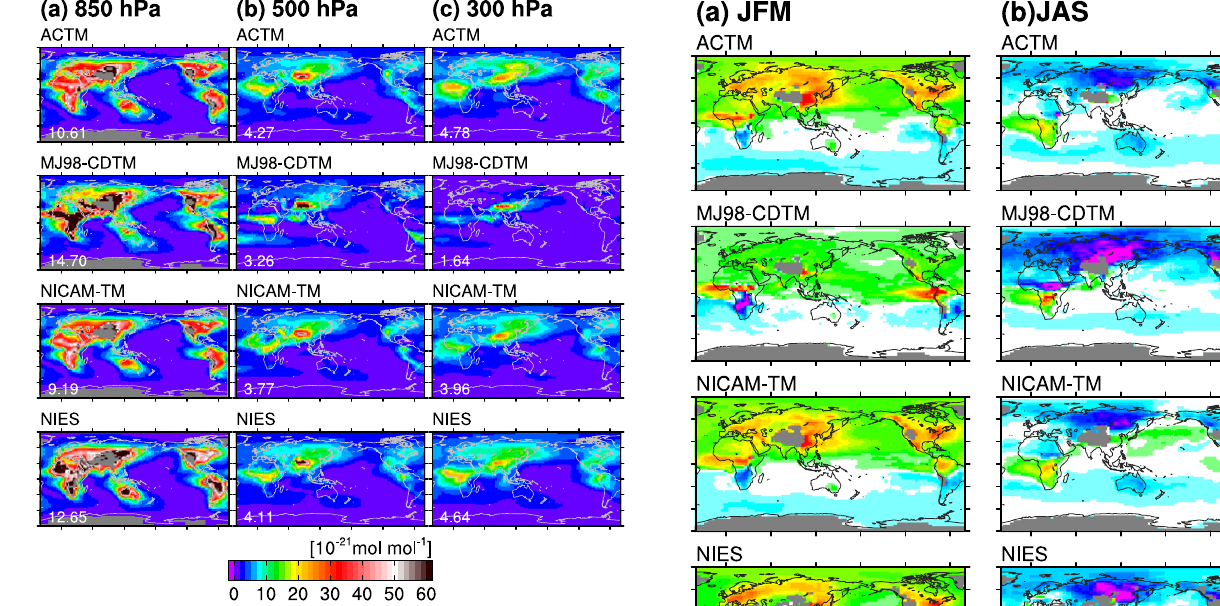
Fig. 3. Longitude–latitude distributions of radon concentrations at 850 hPa (a) , 500hPa (b) and 300hPa (c) for July-August-September (JAS) of 2007 simulated by the models: ACTM (uppermost pan- els), MJ98-CDTM (middle upper panels), NICAM-TM (middle lower panels), and NIES (lowest panels). Values at the lower left corner in panels are the global average of radon mole fraction [10 − 21 molmol − 1 ].